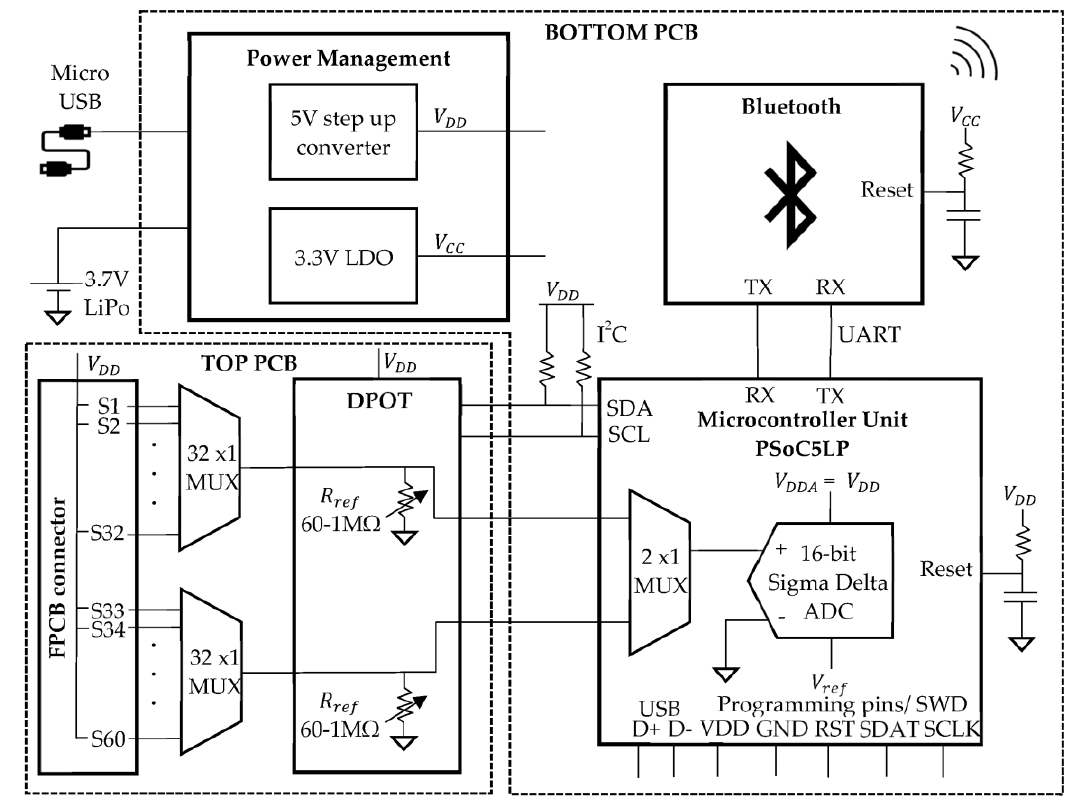
Figure 2. Detailed block diagram of the readout board.